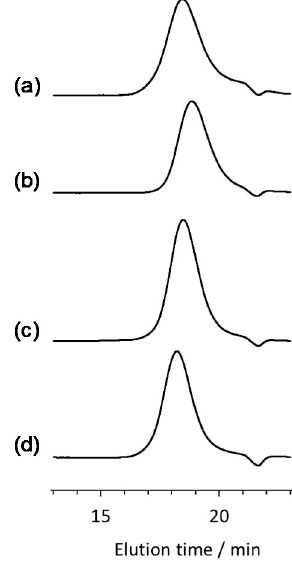
Figure 1. GPC chromatograms of ( a ) P1 , ( b ) P2 , ( c ) P3 , and ( d ) P4 .